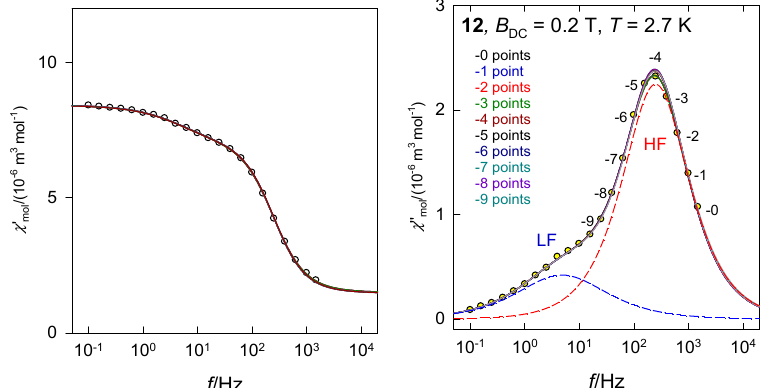
Figure 5. Test of the stability of the fitted relaxation time when 1 to 9 data points from the HF range are gradually omitted. Solid lines for individual fits are overlapped. Dashed lines: Primitive low- frequency (LF) and high-frequency (HF) components. Data adapted from ref. [33] for [Co( biq )Cl 2 ], 12 . 2015, Royal Society of Chemistry.